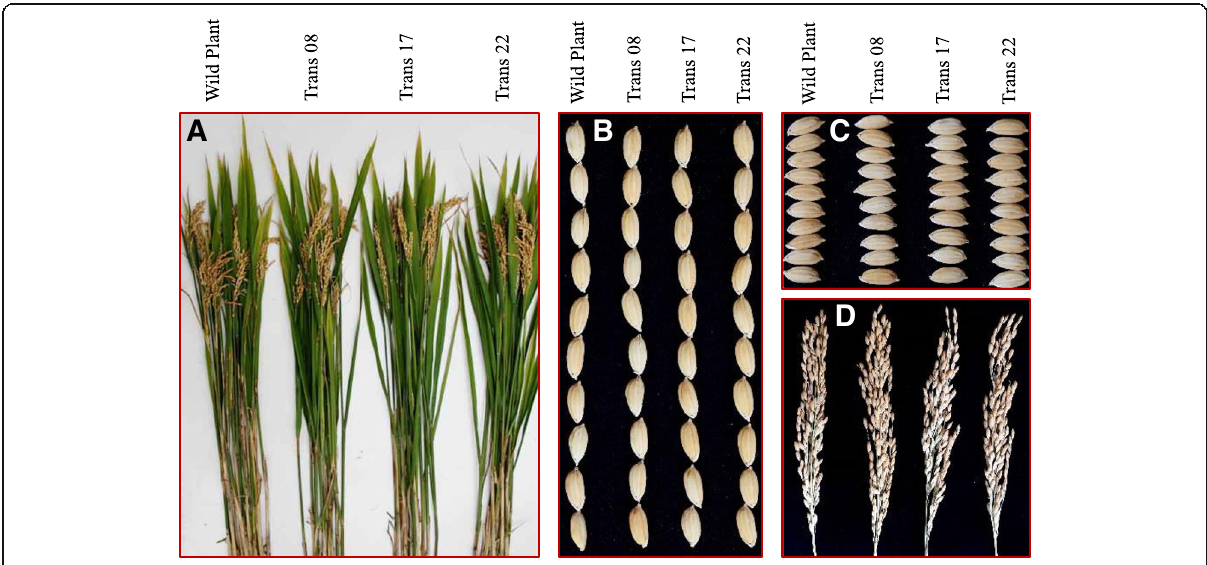
Fig. 7 Phenotype of wild-type cv. XD3 and transgenic lines, Trans 08, 17, and 22. a , Plants inoculated with R. solani YN-17. Panels b , c , and d show seed length, width, and panicles.